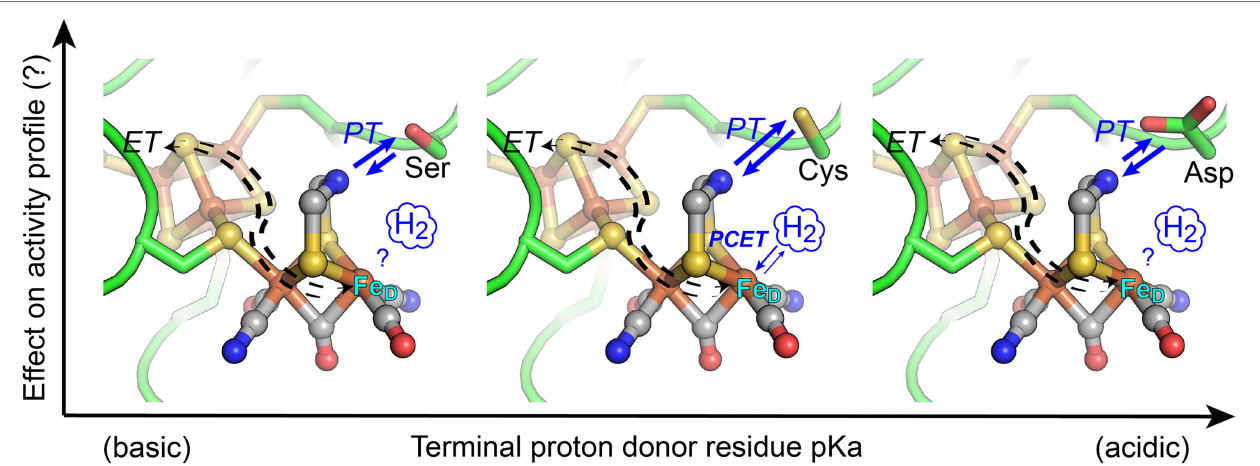
FIGURE 1 | Structural depiction of the [FeFe]-hydrogenase H-cluster active-site where coordination of orthogonal electron transfer (ET) and proton transfer (PT) pathways by proton-coupled electron transfer (PCET) at the distal Fe atom (Fe D ) of [2Fe] H results in catalytic activation of H 2 . In this work, the conserved Cys residue (middle panel), which functions in proton exchange with the H-cluster di(thiolmethyl)amine (DTMA) ligand, was changed to either Ser (more basic pKa, left) or Asp (more acidic pKa, right). The activity profile of enzyme variants was measured to ascertain the extent that engineered variations to the pKa of the exchange step alter reactivity of [FeFe]-hydrogenases. Blue arrows indicate relative changes in the proton transfer direction bias for the variants. Structural representation from PDB 3C8Y, with substitution of Ser or Asp by alignment to PDB